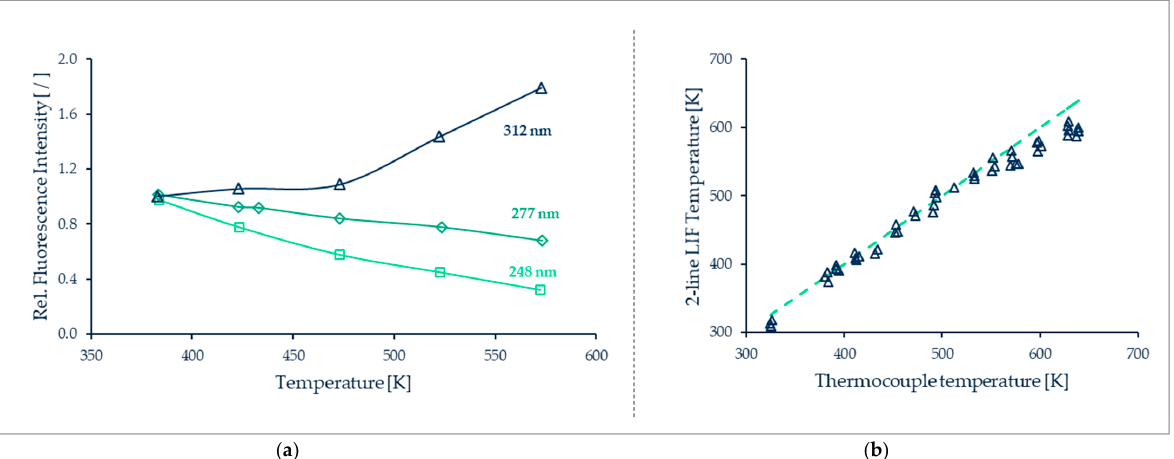
Figure 39. ( a ) Temperature dependence of the relative LIF intensity I f , λ of 3-pentanone, normalized with respect to LIF intensity at 383 K; ( b ) Temperature measurement using the dual-wavelength fluorescence (or two-line LIF) technique with λ 2 = 312 nm and λ 1 = 248 nm, compared to measurements provided by a thermocouple. Data from Grossmann et al. [186]. Data from [186]. Thurber et al. [187] applied the dual-wavelength technique in a measurement of the temperature field of a laminar jet of air seeded with 20% of acetone at atmospheric pressure. The employed excitation wavelengths were 308 and 248 nm. The jet, issued from a 10 mm nozzle at a Reynolds number Re = 60, was heated to 515 K on its center line. Planar laser-induced fluorescence (PLIF) was implemented in order to tag the tracer molecules in the plane illuminated by the laser sheet. The two images obtained from the two excitations with different wavelengths were collected by the same CCD. The experiments revealed temperature variations in the flow from 300 to 525 K. The measurement uncertainty was estimated to be 0.6% (Figure 40a). Later on, Thurber and Hanson [185] applied the same technique to a turbulent jet at a Reynolds number 5100 Re = , with very good results. The air at atmospheric pressure was seeded with 9% acetone, and the flow issuing a 1.7 mm diameter nozzle was heated to 465 K. Important information on the spatial resolution of the measurement was given: a region of the flow of 33 × 42 mm 2 was investigated and the CCD allowed a spatial resolution of 6.7 μ m per pixel. However, in order to improve the signal to noise ratio, a 2 × 2 binning procedure was used (Figure 40b). The temporal resolution was 500 ns. The uncertainties reported on the temperature measurement gradients were the same as in their previous work, but with a slight offset of 10 K in the absolute values. This offset was attributed to the non-homogenous seeding tracer concentrations from the inner to the outer flows. It is to be noticed that this setup allowed the performing of parallel measurements of temperature and tracer molar fraction. In this case, the techniques are greatly complexified [185].